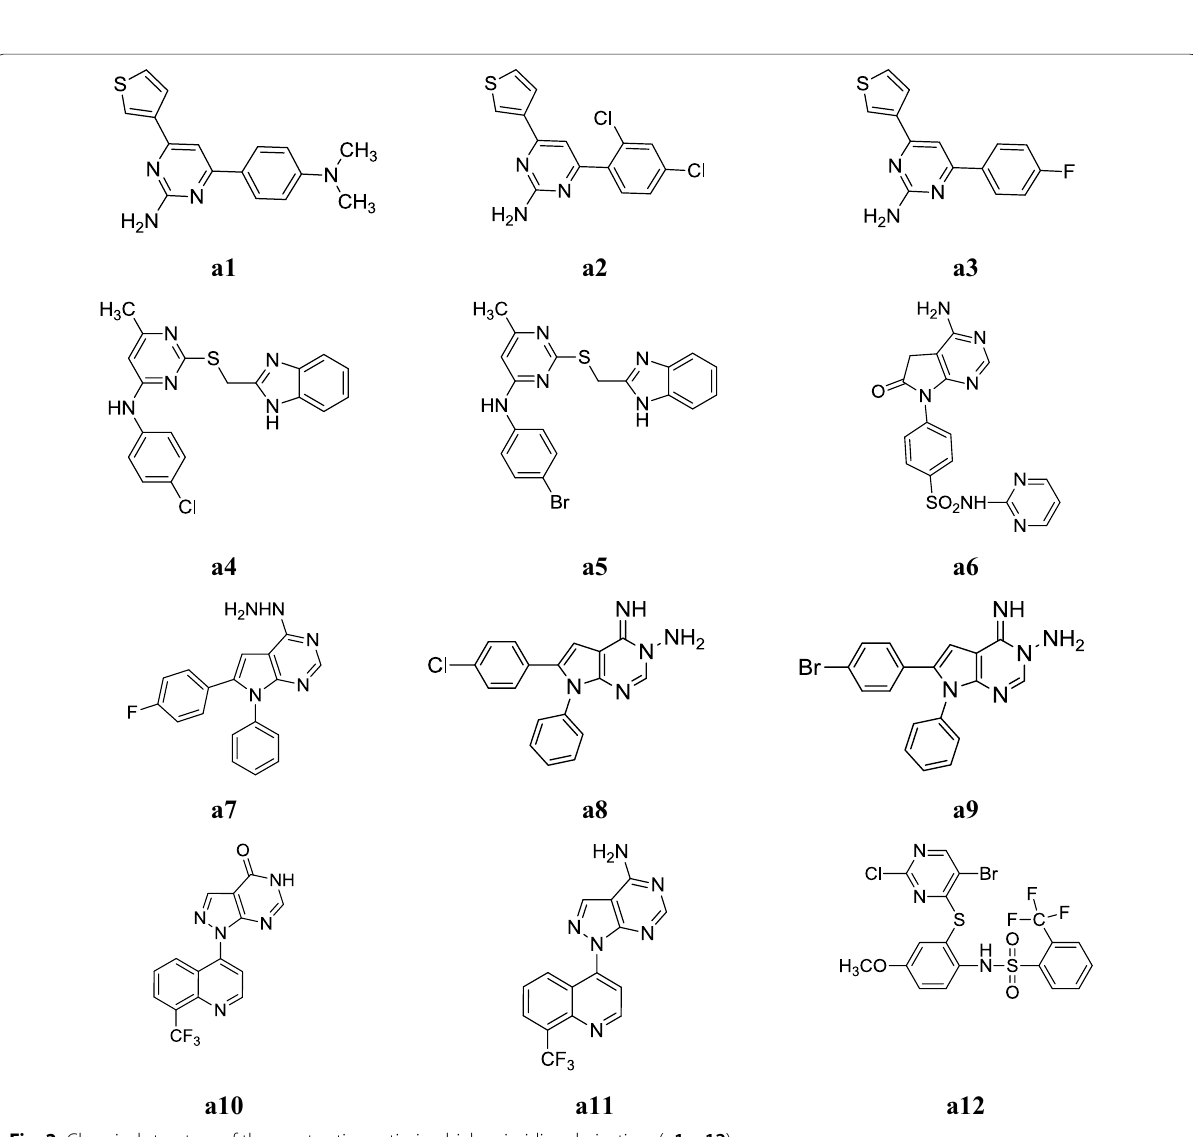
Table 2 Antimicrobial activity (MIC Compounds Bacterial